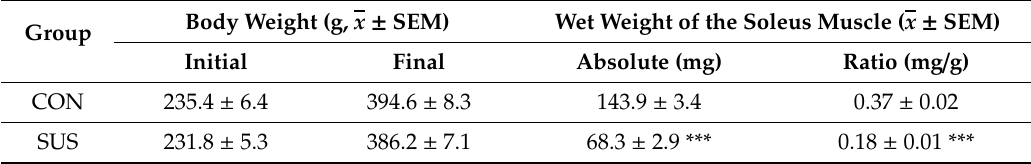
Table 1. Body weight and wet weight of the soleus muscle of rats in CON and SUS group. Body Weight (g, x ± Group